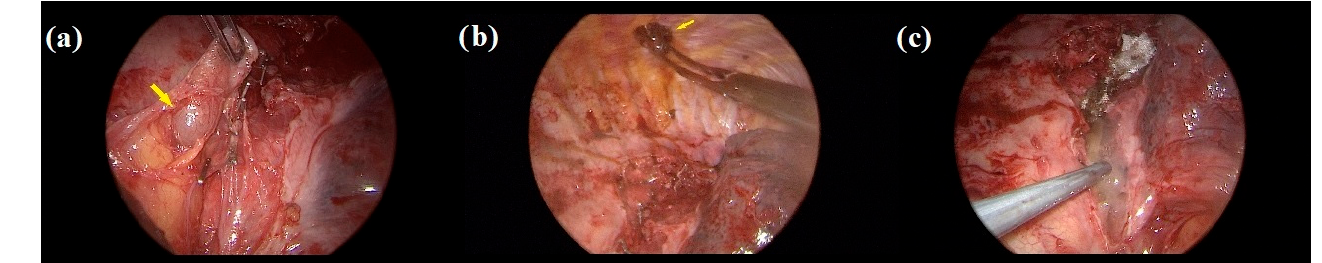
Figure 3. Thoracoscopic pitch images of the surgery, after complete hemangioma excision: ( a ) removal of the posterior thoracic gland (arrow) and duct clipping; ( b ) parietal pleurodesis with an iodopovidone-soaked sponge (arrow); ( c ) the residual surgical field is sealed with absorbable hemostatics.